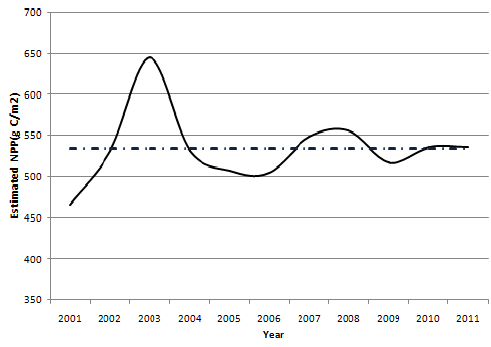
Figure 4. The NPP value from the year 2001 to 2011.